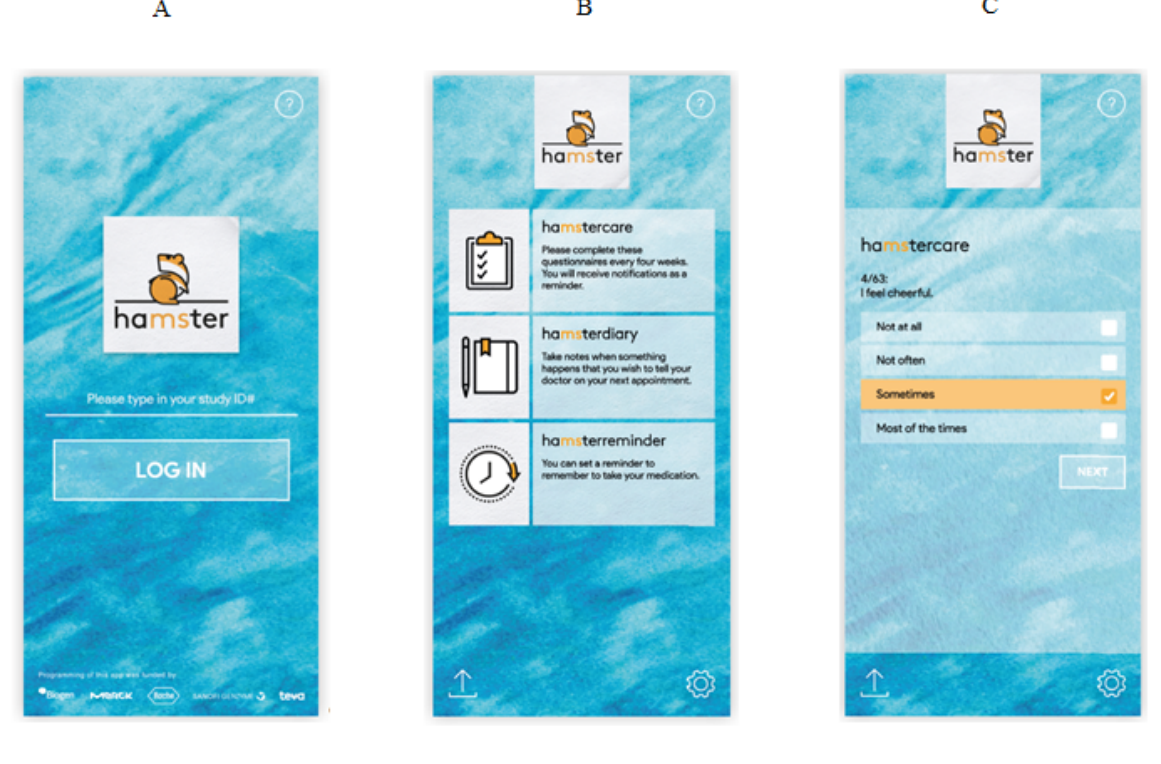
Figure 2. Screenshots of the the login screen (A), main menu screen (B), and a sample patient-reported outcome (PRO) question (C). The screenshots provided here have been translated from German to English for the purpose of this article. The lower end of the log-in screen reads “Programming of this app was funded by” and lists the corporate logos of pharmaceutical companies that provided funding for programming the haMSter app.